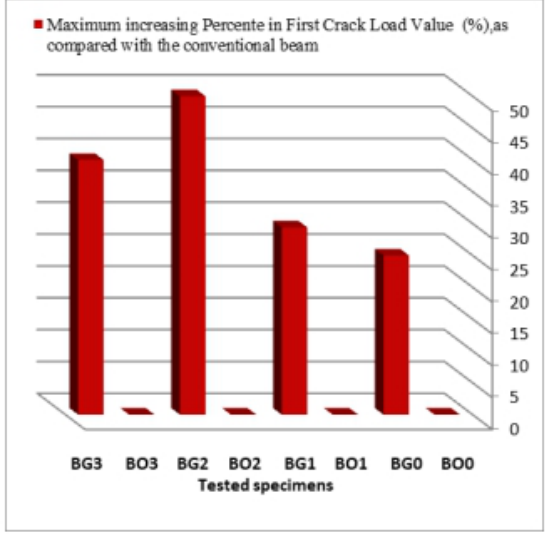
Fig. 7. Increasing Percent in Maximum load of Beams Tested